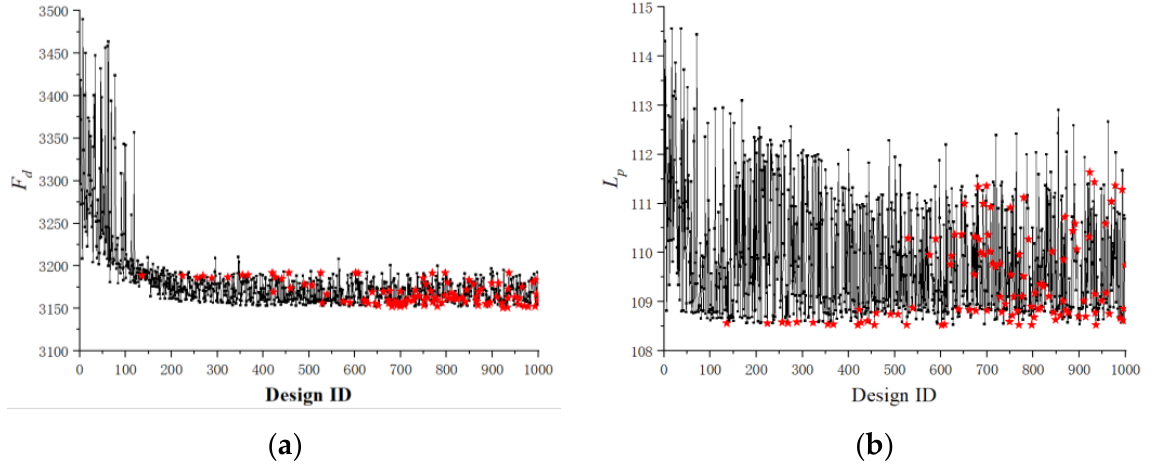
Figure 8. Histories of objective variables: ( a ) Aerodynamic resistance, ( b ) Dipole noise source.